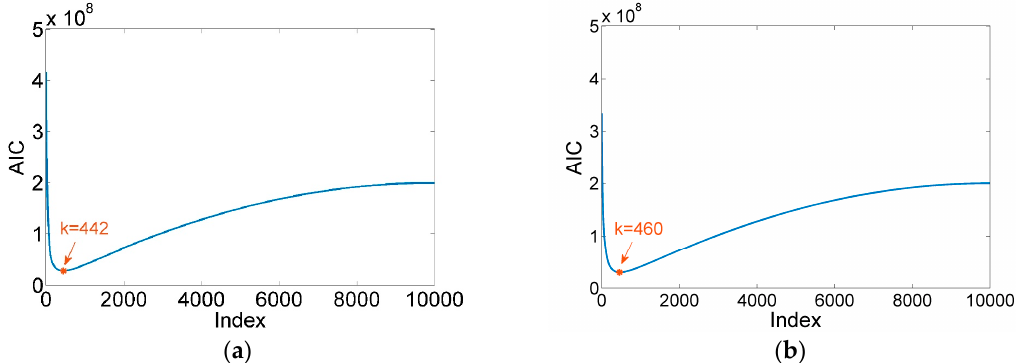
Figure 14. AIC diagrams at different rotational speeds: ( a ) 1800 rpm; ( b ) 2000 rpm.